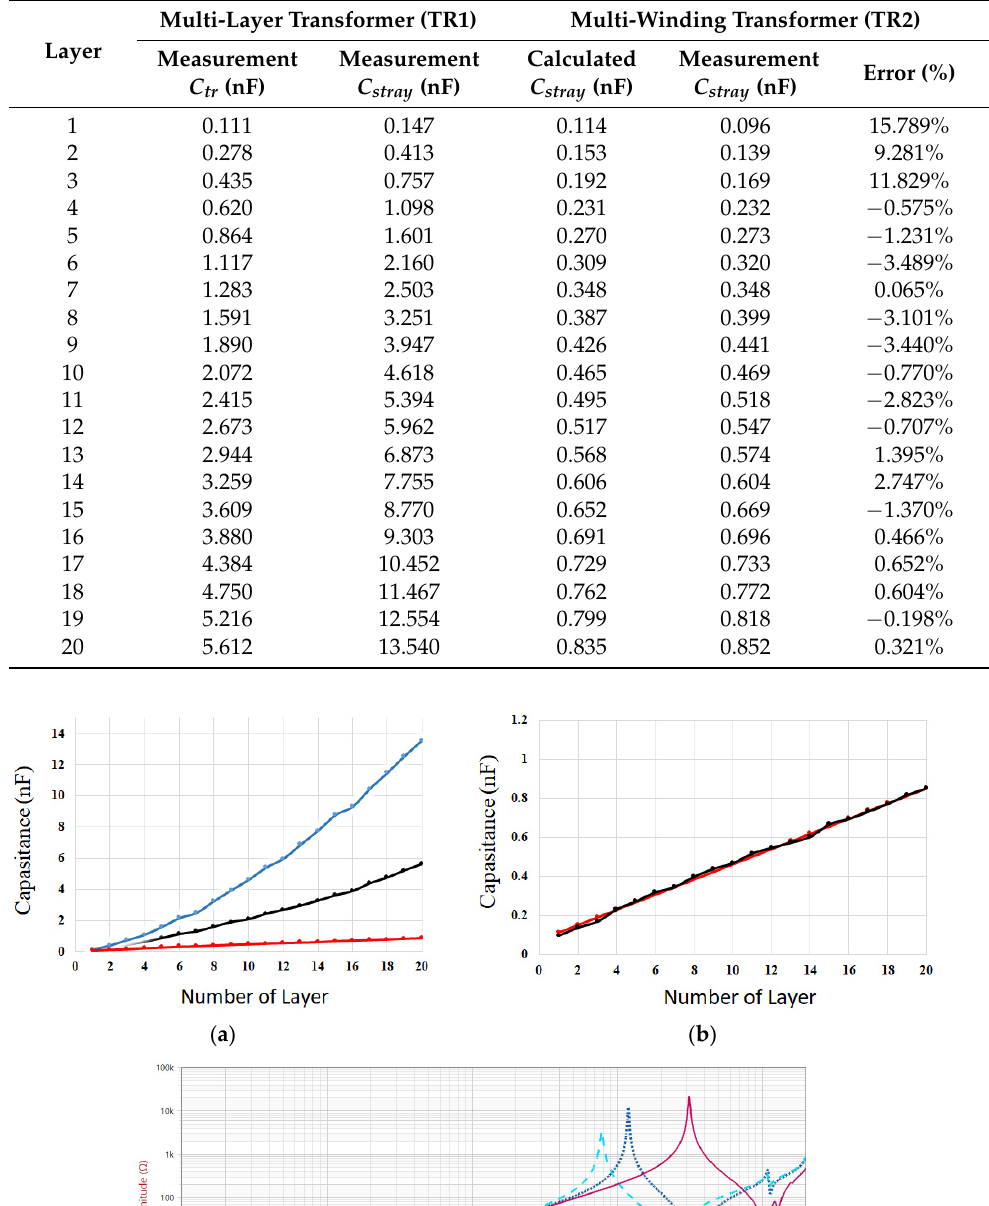
Table 2. Capacitance calculations and measurements for TR1 and TR2.